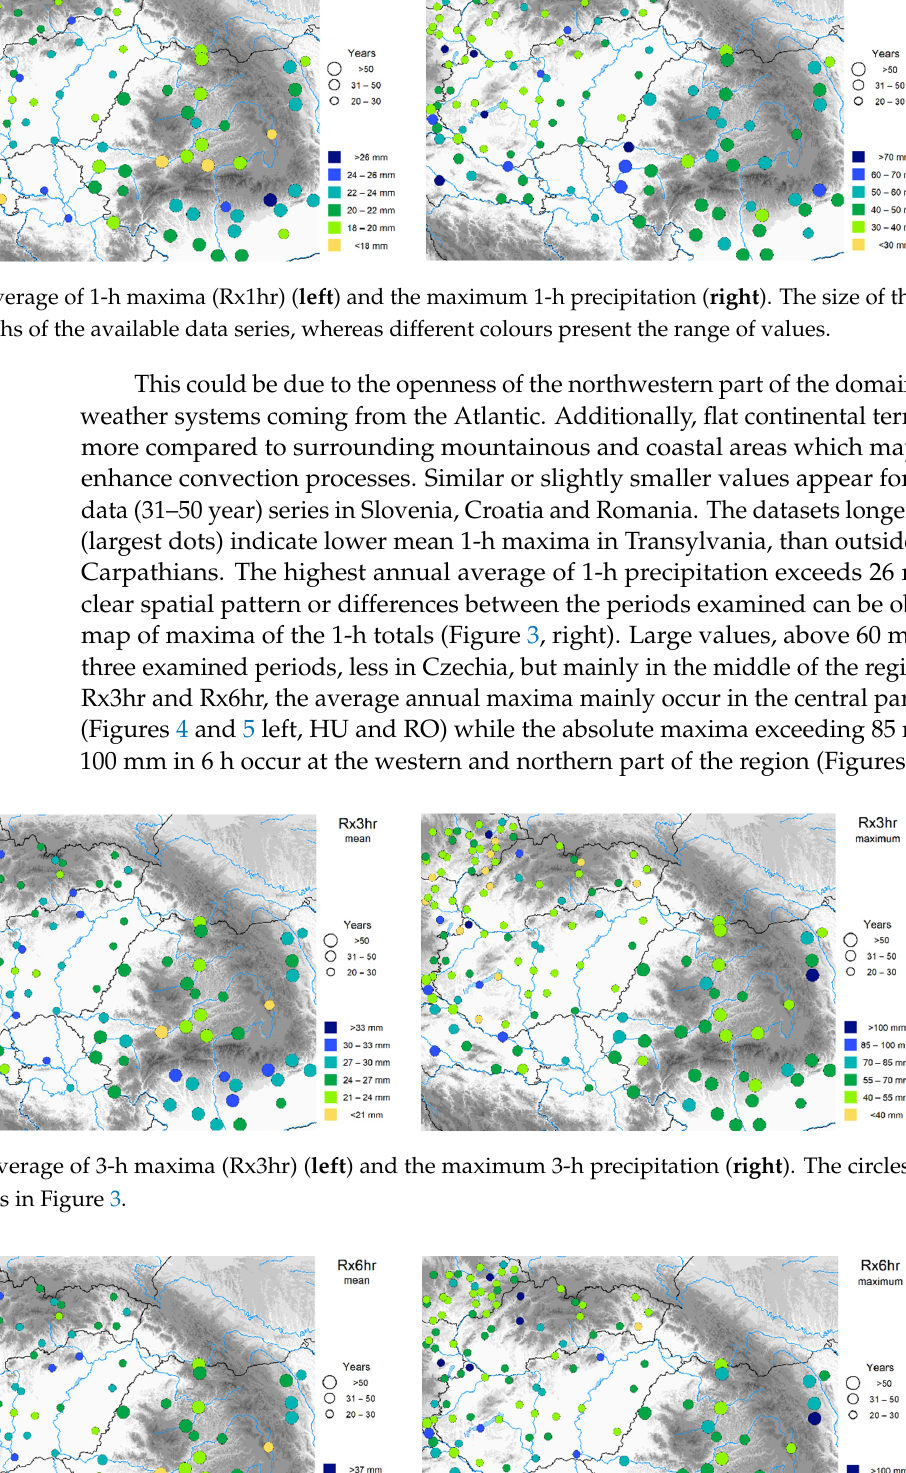
Figure 5. Annual average of 6-h maxima (Rx6hr) ( left ) and the maximum 6-h precipitation ( right ). The circles and their sizes are the same as in Figure 3.